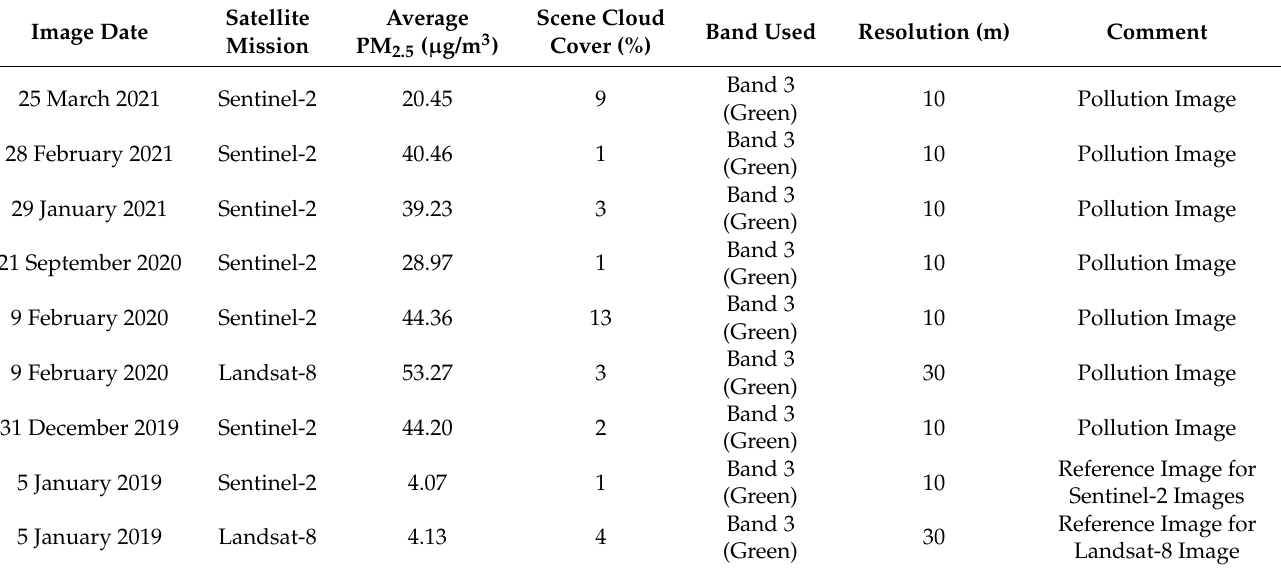
Table 1. Reference and pollution images used in the